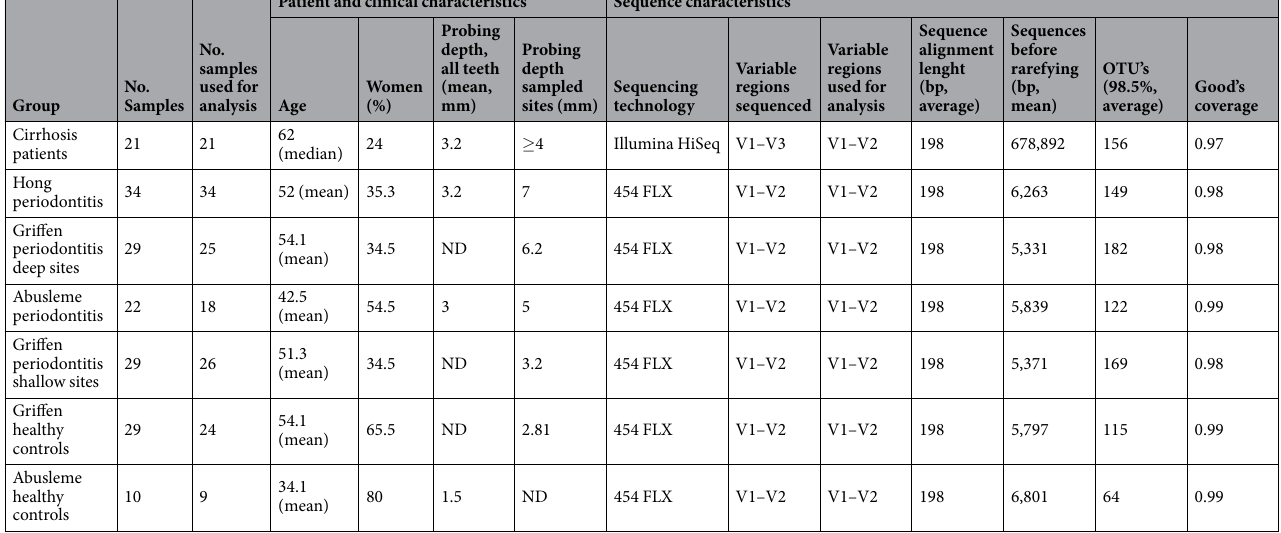
Table 2. Clinical and sequence characteristics for all dataset used for